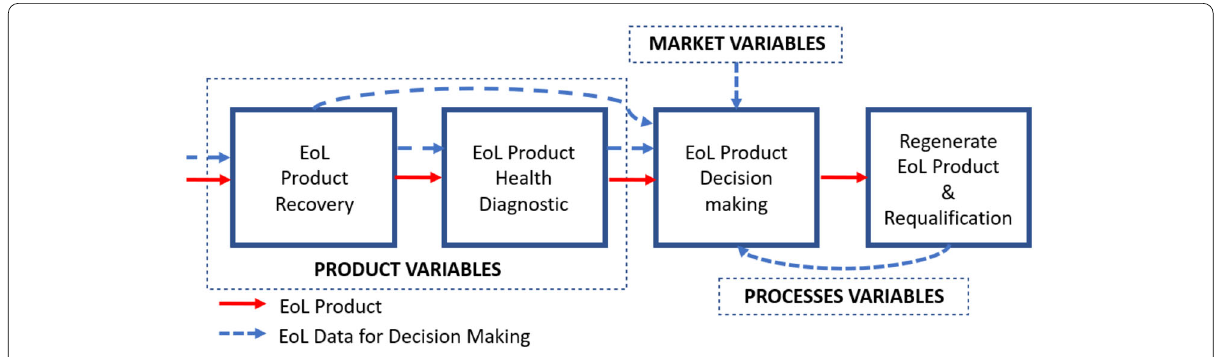
Figure 1 Example of regeneration activities